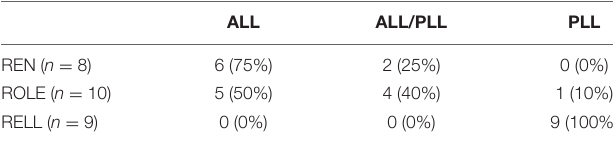
Number of inhibitory efferent cells projecting to the ALL and PLL.